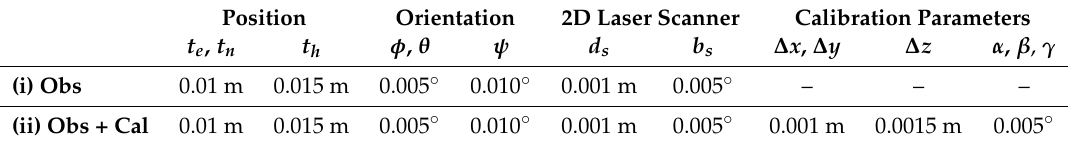
Table 1. Standard deviations for the error propagation of the georeferencing equation (Equation (2)). Position Orientation 2D Laser Scanner Calibration Parameters